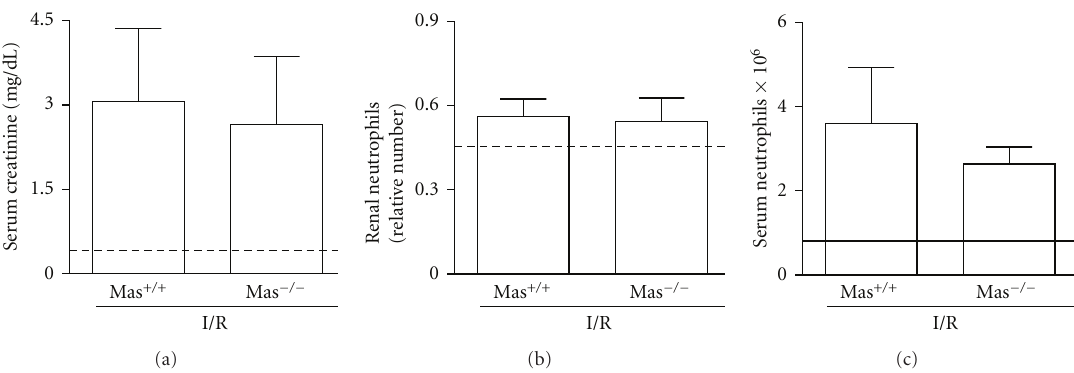
Figure 3: Ischemia and reperfusion in mice with genetic deletion for the Ang-(1–7) Mas receptor (Mas − / − ) or WT mice (Mas + / + ). Animals were subjected to 30 min of ischemia followed by 24 h of reperfusion. Serum creatinine (a), relative number of neutrophils in renal tissue (b), and number of neutrophils in blood (c) are shown as the mean ± SEM of six mice per group.